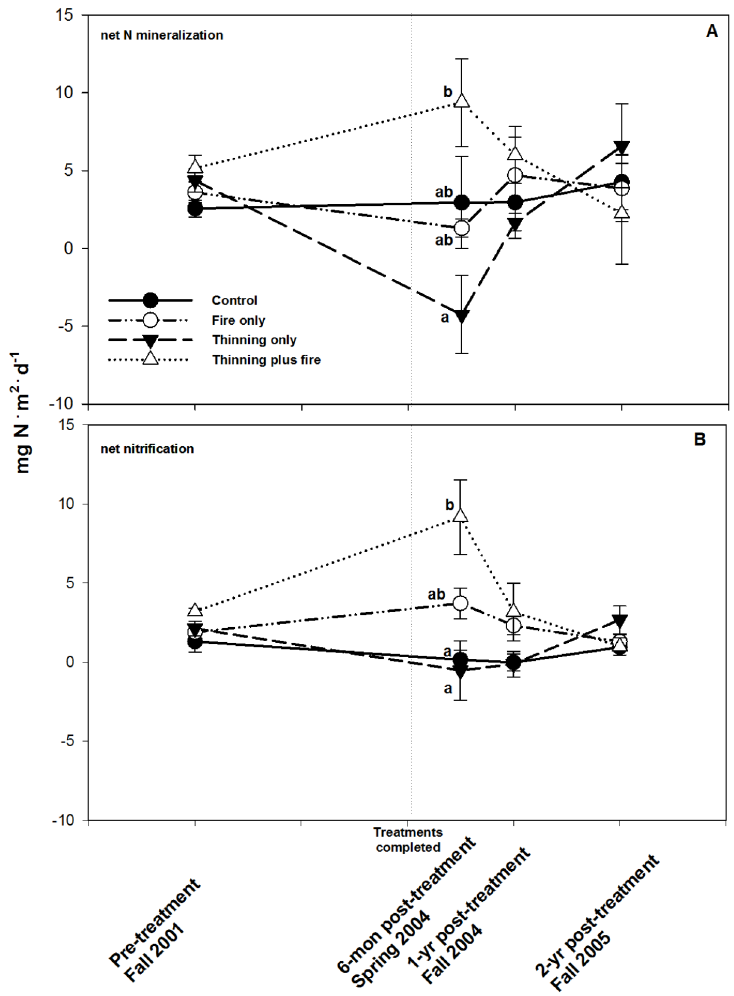
Figure 6. Mean ± one standard error ( n = 3) net nitrogen (N) mineralization (A) and nitrification rates (B) in mineral soil (0–15 cm) at the Southwestern Plateau, Fire and Fire Surrogate study site pre- and post-fuel reduction treatments. Different letters for a given sampling date indicate significant differences, but sampling dates that share letters are not significantly different ( α = 0.05) using Tukey-Kramer pairwise comparison following a significant repeated measures, generalized linear mixed model analysis of treatments. When no letters are provided, mean values among treatments were similar statistically.